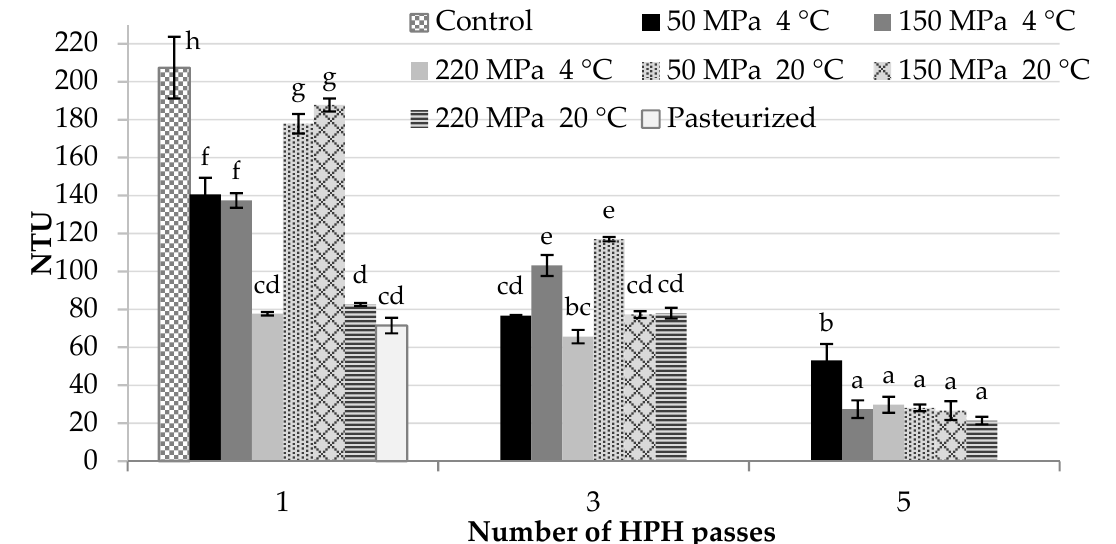
Figure 1. Nephelometric turbidity of cloudy blackcurrant juice treated with high-pressure homogenization, or pasteurization. The values with different superscript letters are significantly dif- ferent ( p < 0.05).